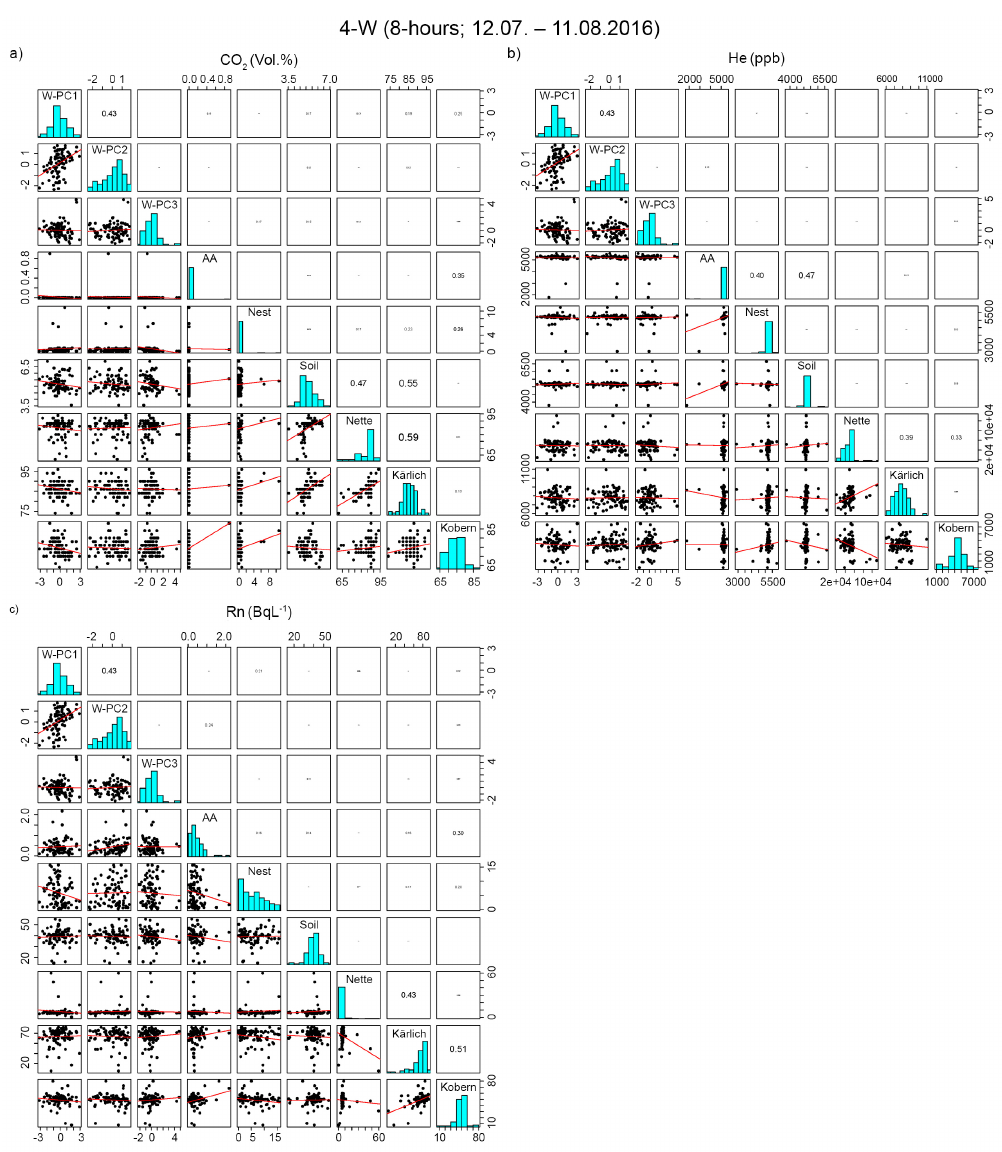
Figure A2. Correlation coefficients of the principal components analysis of weather variables with geogenic gas concentrations for ( a ) CO 2 , ( b ) He, and ( c ) Rn for AA, NG, SG, and the three mineral springs for the 4-W samples; W-PC1 =